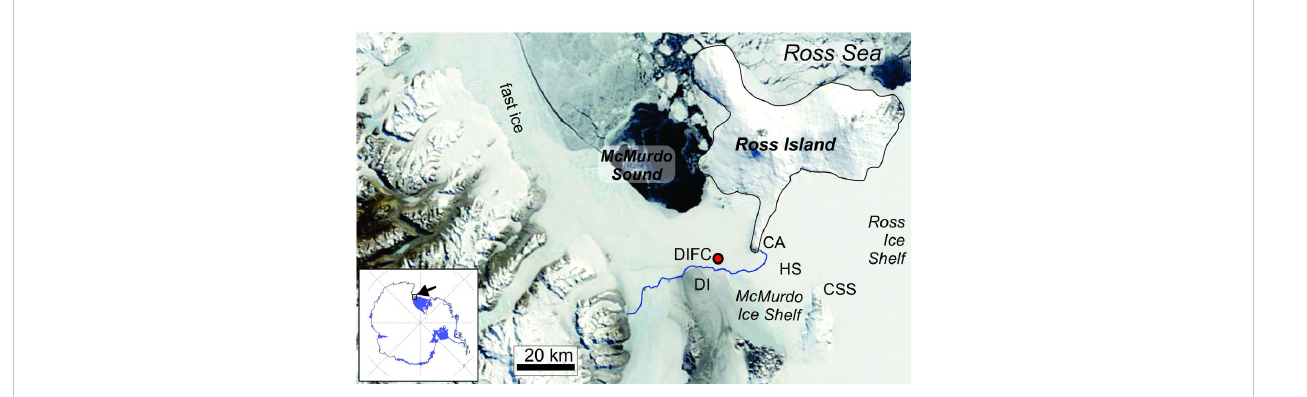
FIGURE 1 Location details including McMurdo Sound as an exit point for the Ross Ice Shelf cavity (showing DIFC=Dirty Ice Field Camp, HS=Haskell Strait, CSS=Cape Spencer-Smith, CA=Cape Armitage). The inset shows Antarctica and ice shelf margin shown in blue with McMurdo Sound sub-region identi fi ed. The Modis imagery is from 10 November 2015 day 314 showing the dark smudge of the “ dirty ice ”